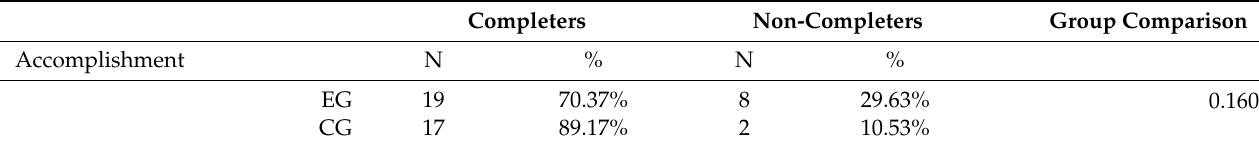
Table 5. Comparison between completers ( ≥ 75%) and